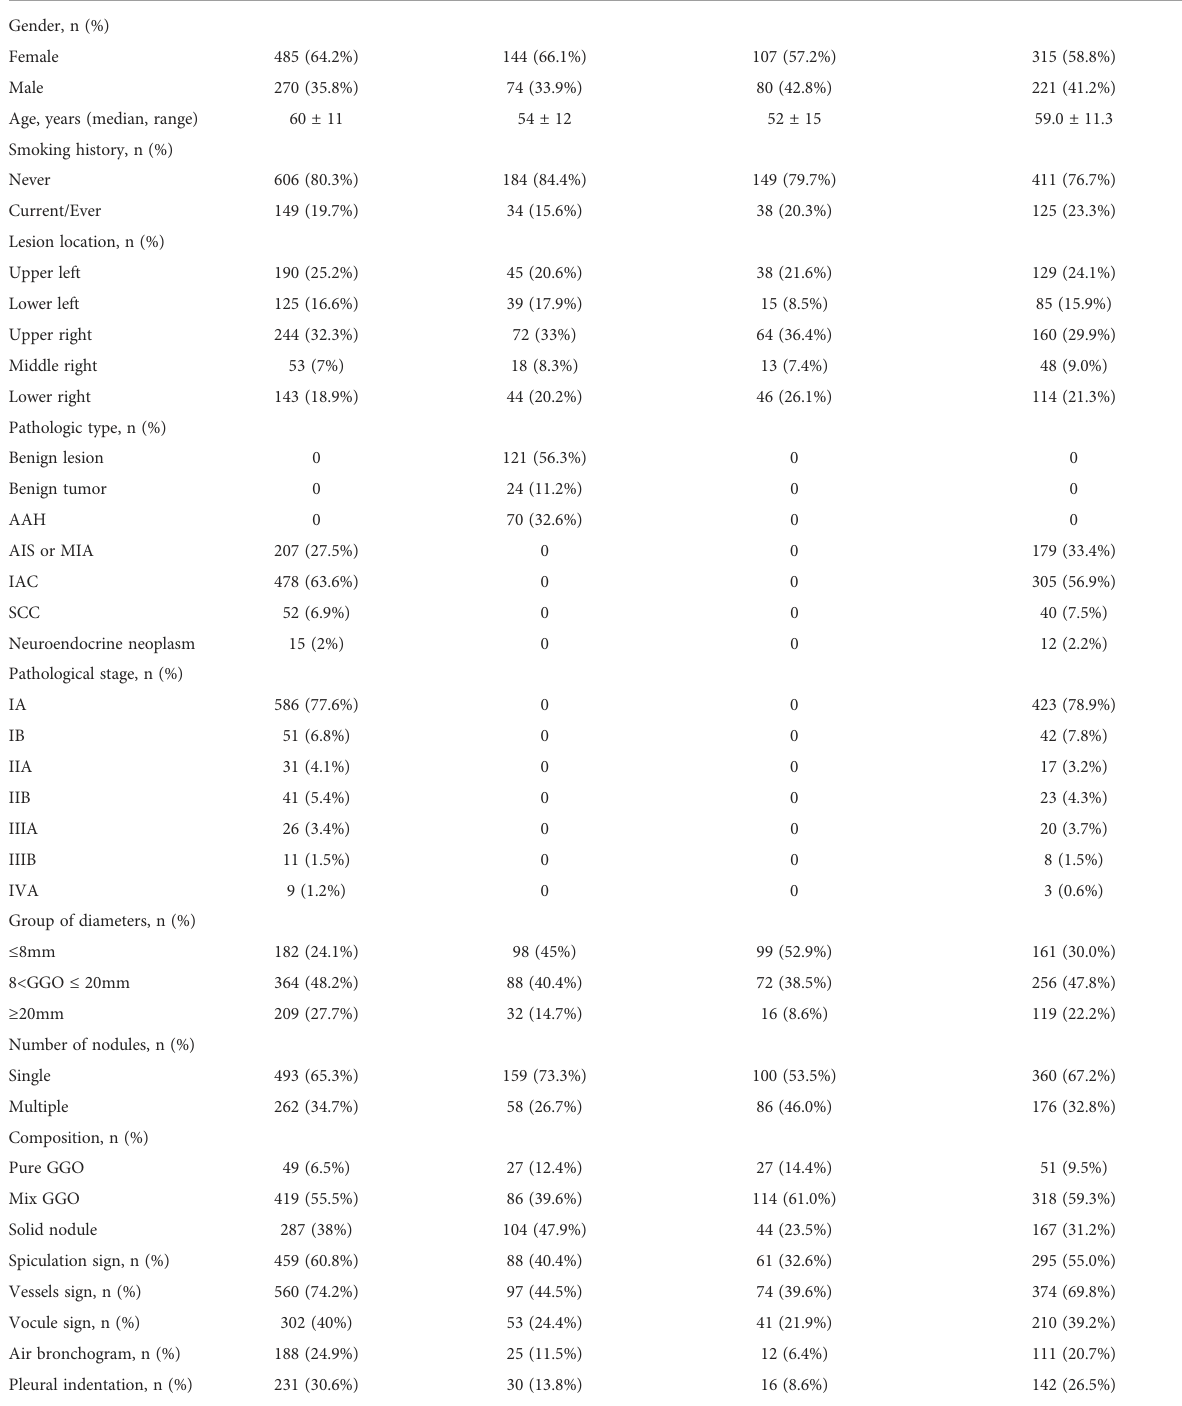
TABLE 2 Baseline clinical characteristics of patients with surgically resected lung nodules. Validation